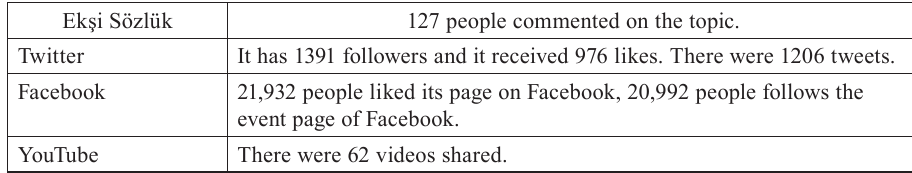
Table 1. Participant Information (source: created by authors) Ekşi Sözlük 127 people commented on the topic.